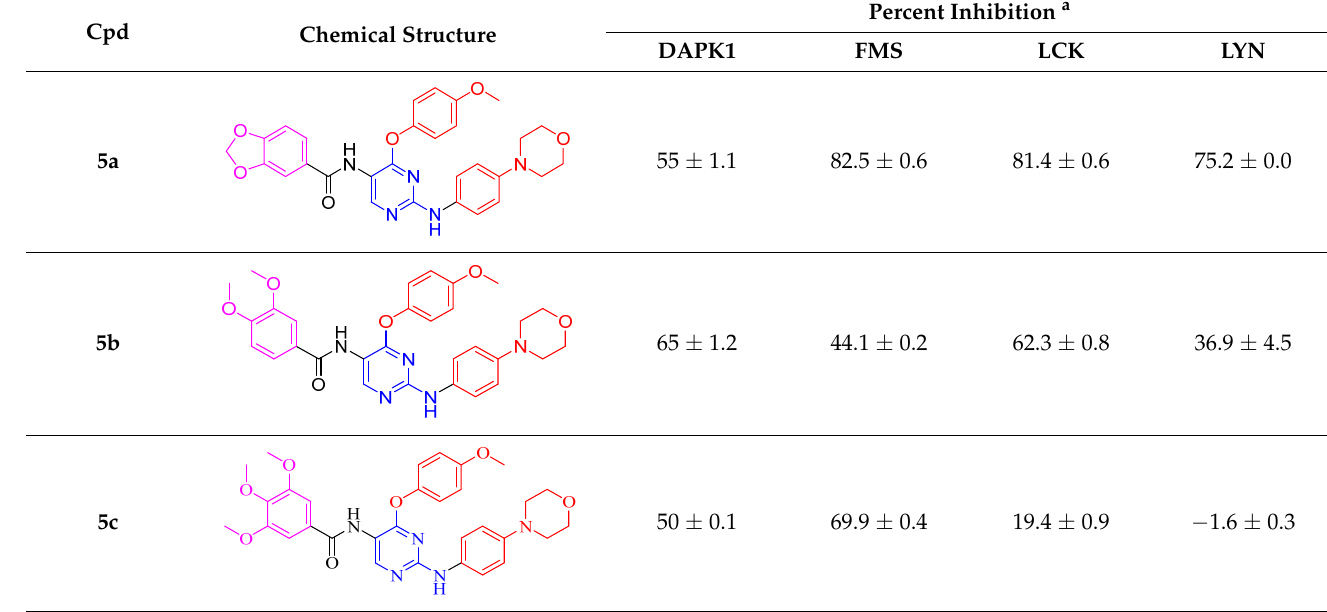
kinases in comparison to the results obtained for compound 5a . Table 2. Percent inhibition values of the synthesized compounds 5a–5g over the selected kinases at a single dose concentration of 10 µM.